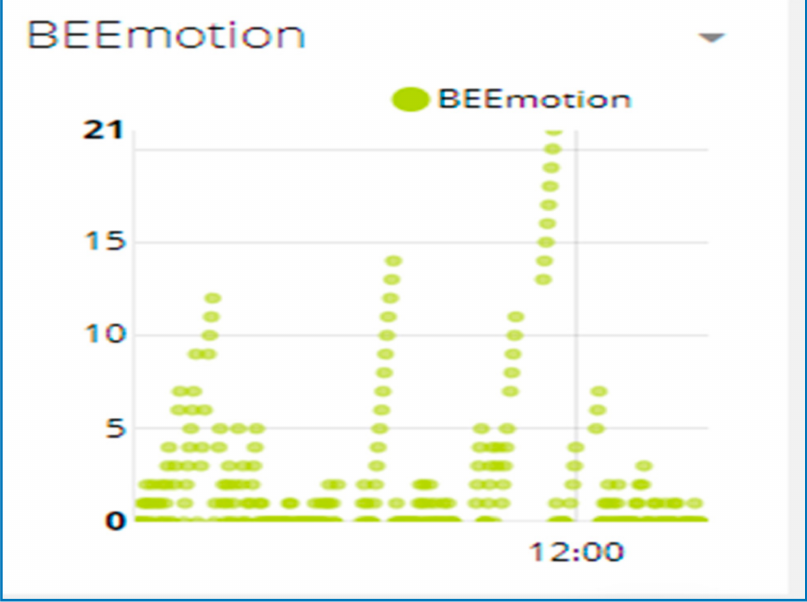
Figure 21. The graph of bees’ motion.